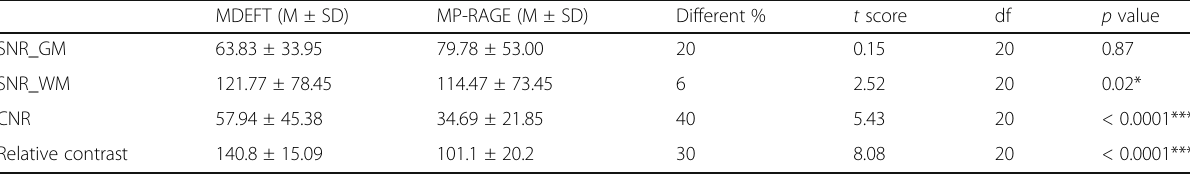
Table 2 The mean SNR, CNR, and relative contrast between MDEFT and MP-RAGE pulse sequences